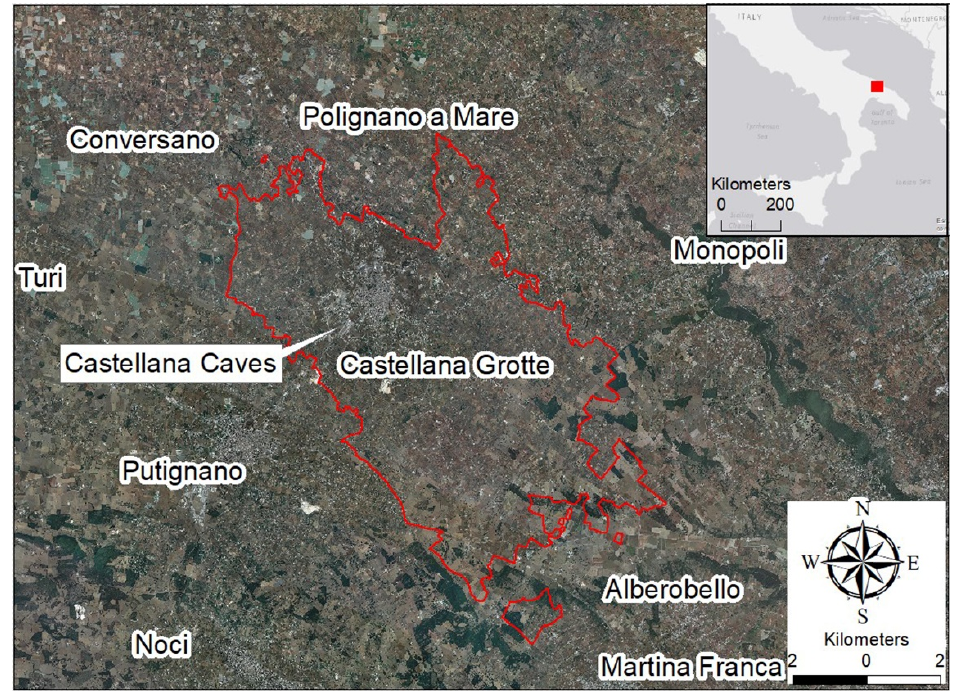
Figure 9. Location of the Castellana Caves, in Apulia, southern Italy.